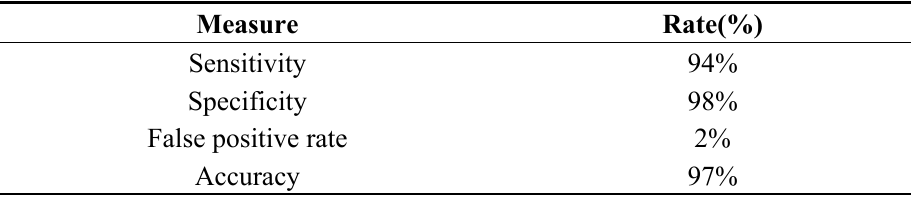
Table 2. System performance